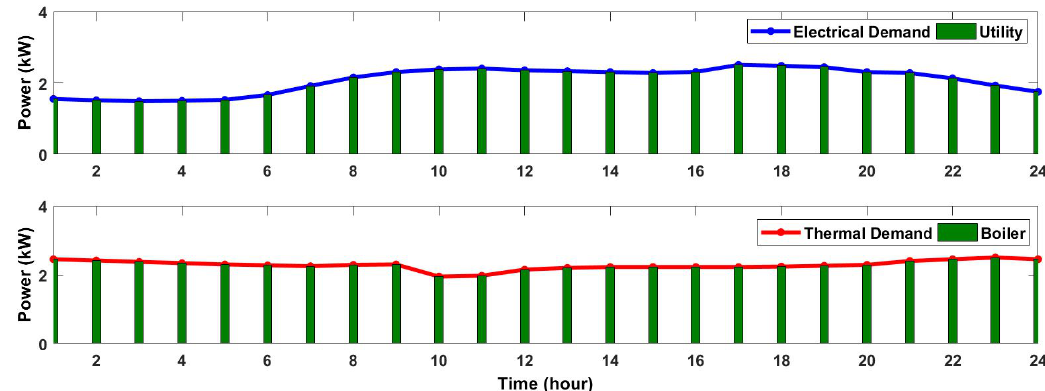
Figure 6. Case 1: Basic operation mode of house.